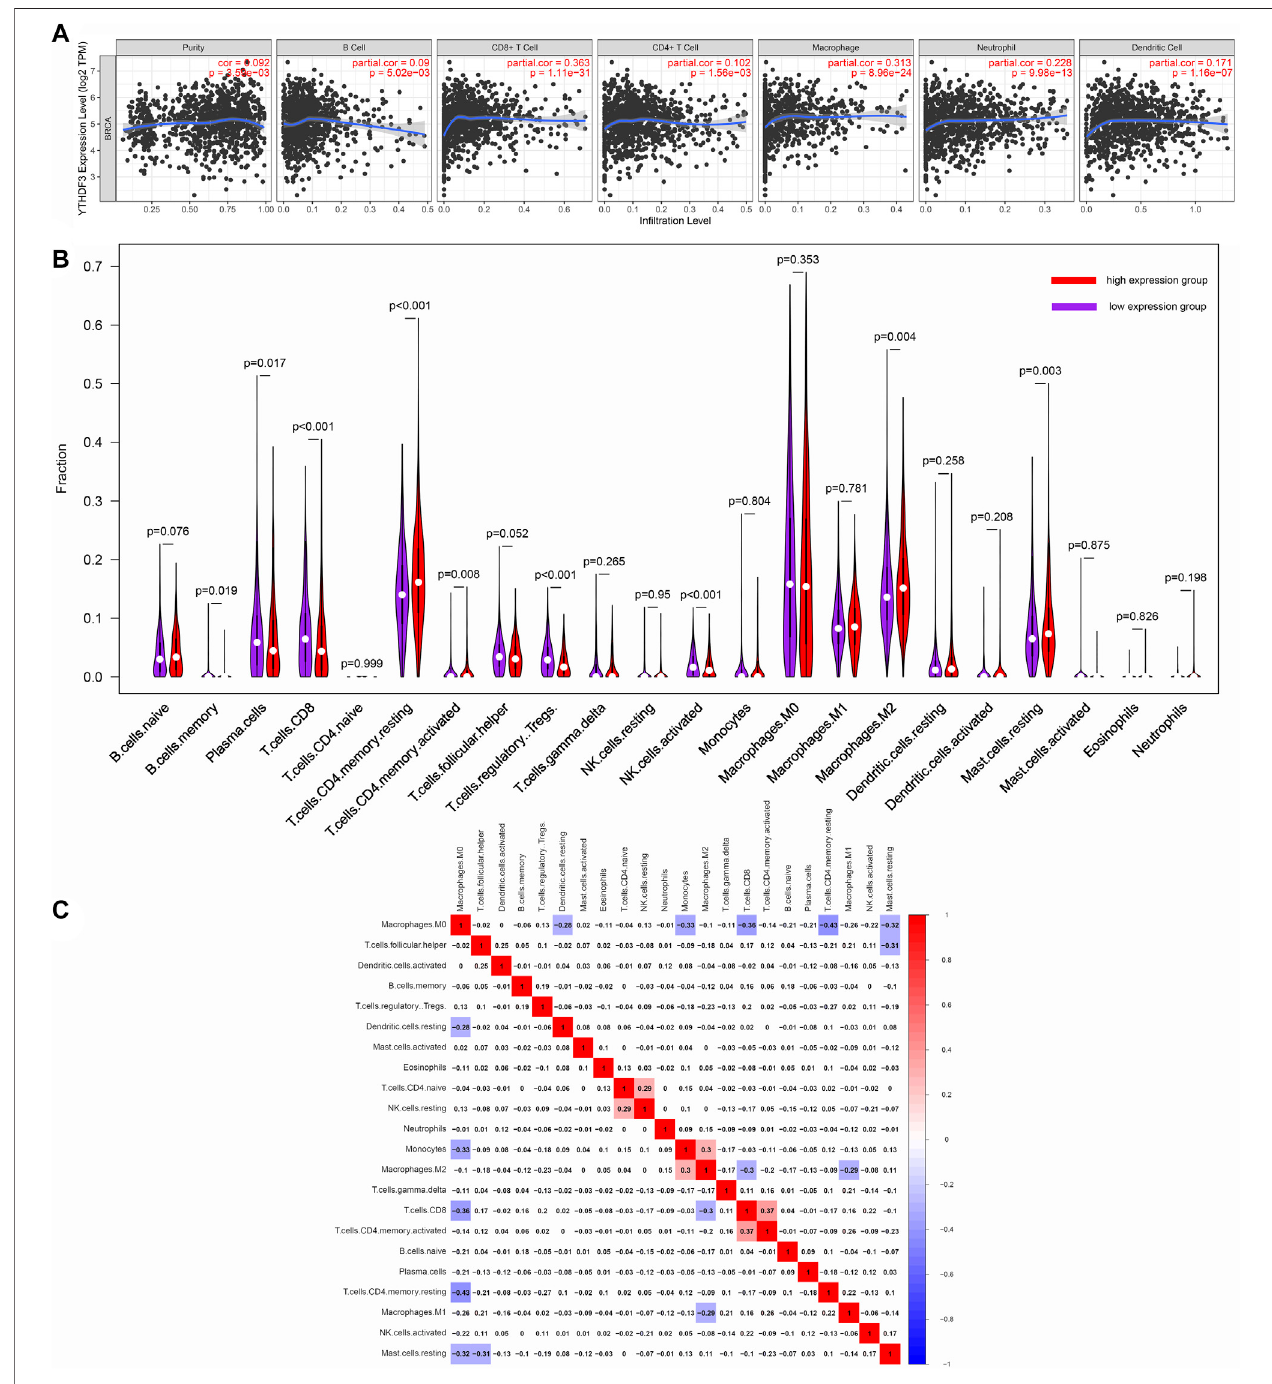
FIGURE 3 | (A) Relations between YTHDF3 expression and the in fi ltration of immune cells. (B) Diverse fractions of immune cell subpopulations in high- and low- YTHDF3 expression groups. (C) Heatmap of immune cells in BC.